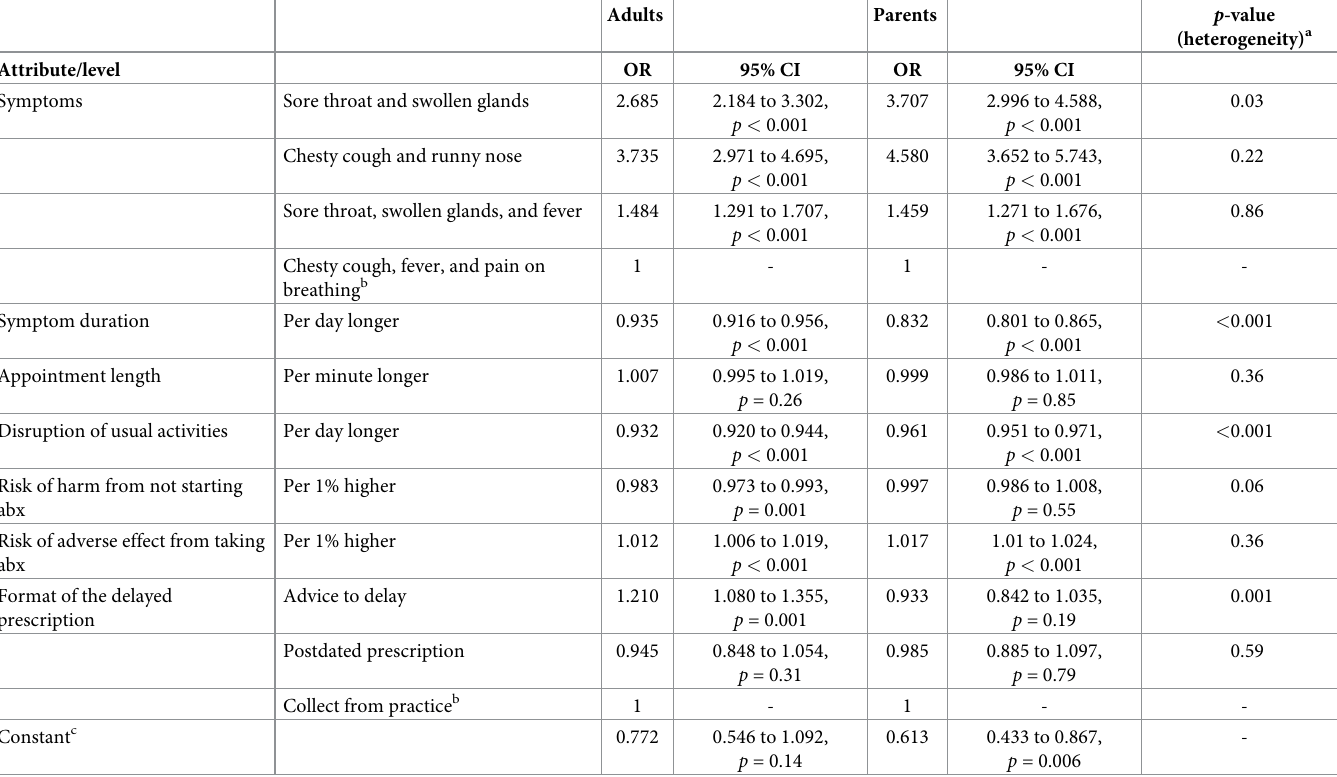
Table 4. Effect of attributes on preferences for delayed